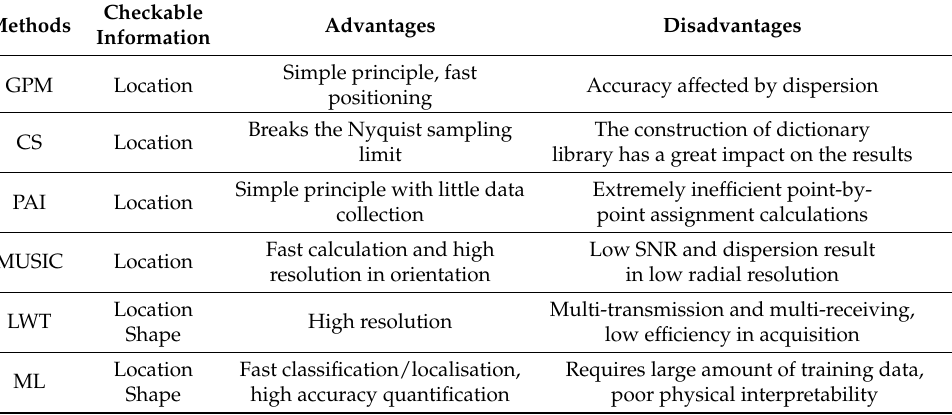
Table 4. Comparison of detection methods based on a small amount of wavefield data.